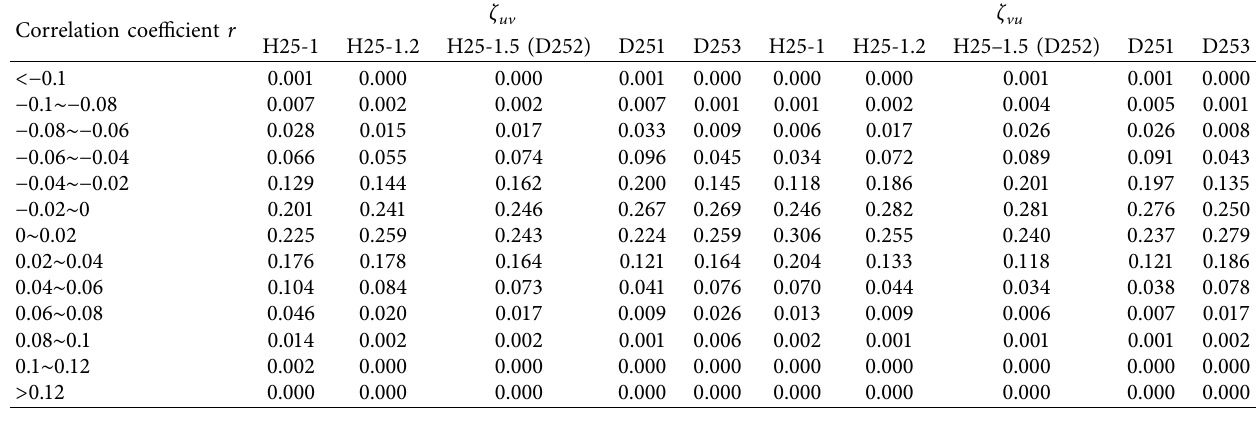
Table 4: The value of ζ uv and ζ vu in different working conditions.